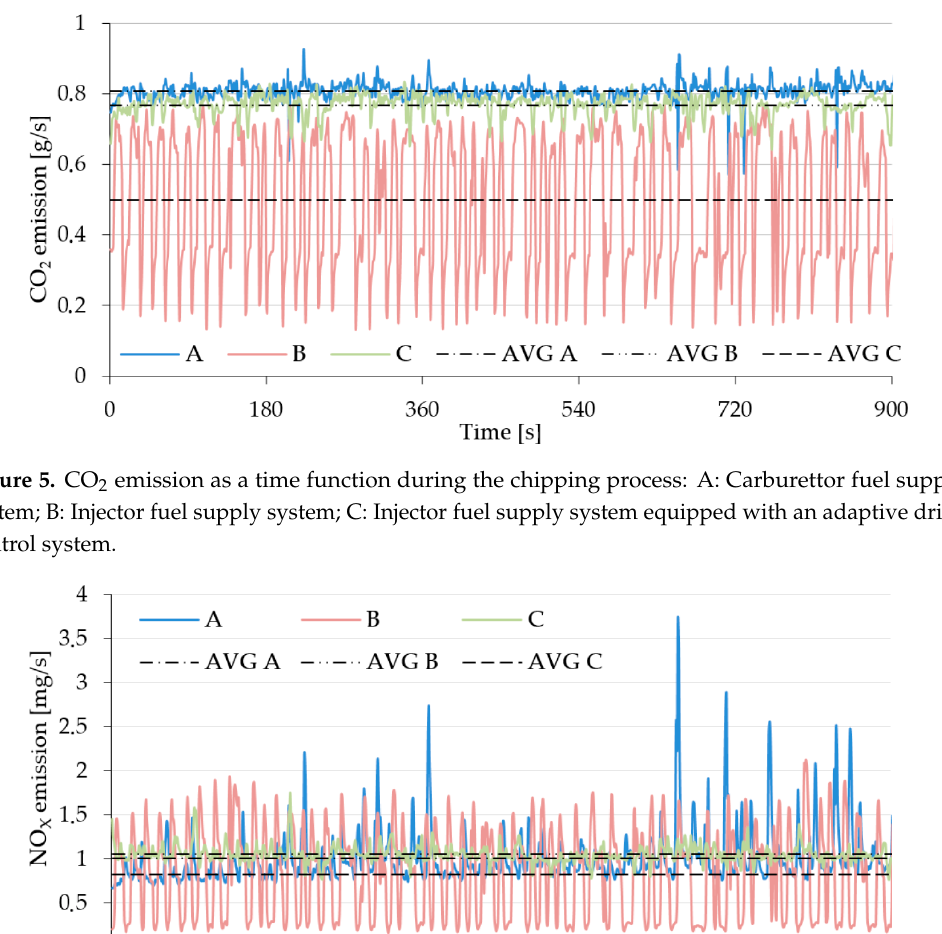
Figure 4. CO emission as a time function during the chipping process: A: Carburettor fuel supply system; B: Injector fuel supply system; C: Injector fuel supply system equipped with an adaptive drive control system.